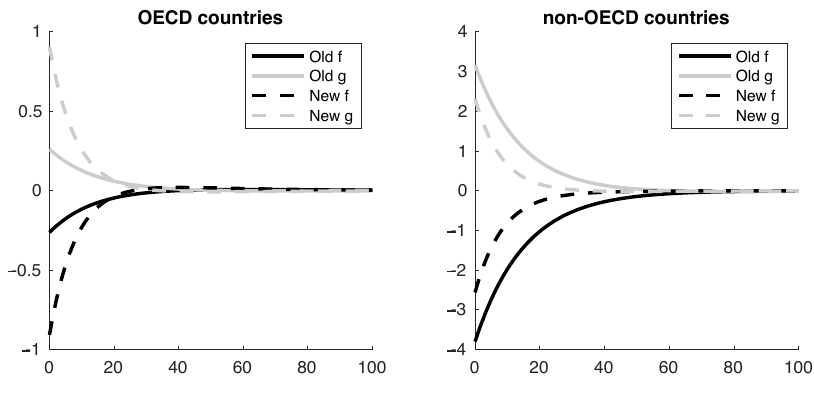
Figure 15. Control variables, simulation with π .